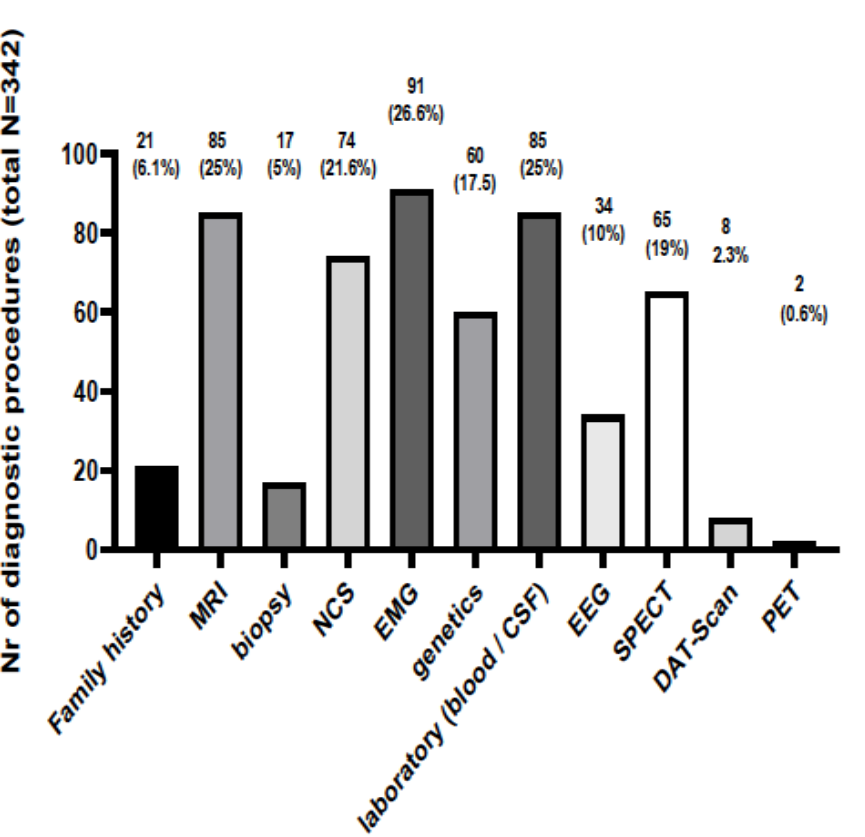
Figure 2. The number of diagnostic procedures and the clinical data that led to the diagnosis of a Rare Neurological Disease. MRI: Magnetic Resonance Imaging; NCS: Nerve conduction study; EMG: Electromyography; CSF: Cerebrospinal fluid; EEG: Electroencephalography; SPECT: Single-photon emission computed tomography; DAT-Scan: Dopamine Transporter Scan; PET: Positron Emission Tomography. Table 2. Number of Rare Neurological Diseases in which a genetic test was undertaken; the genetic results and the confirmation rates are also presented.